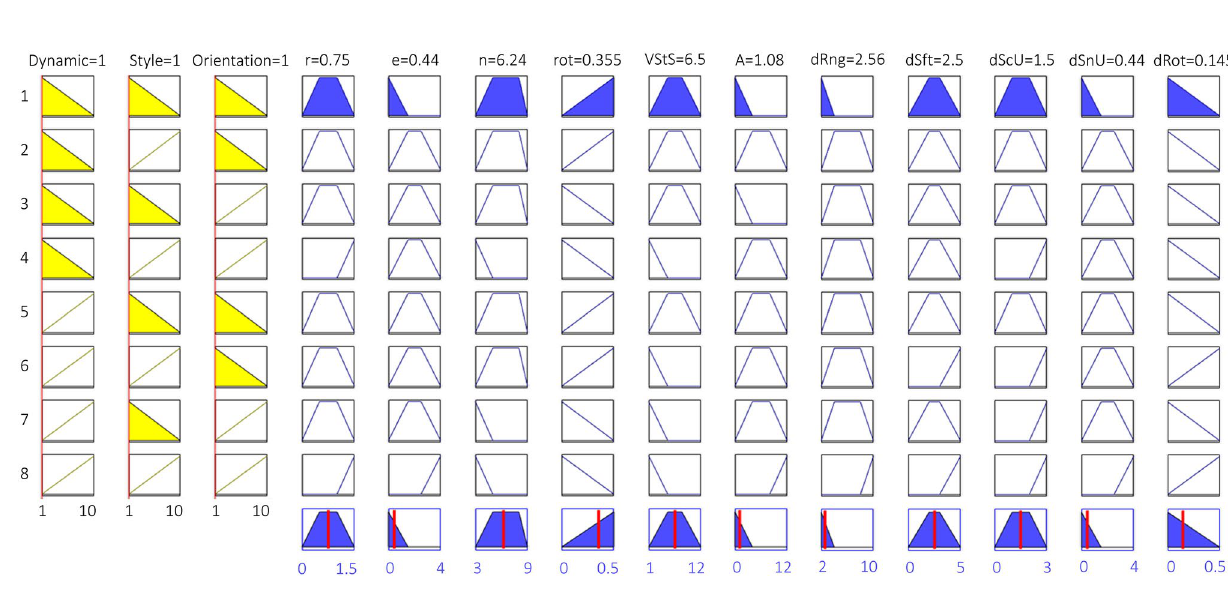
Fig. 9 Fuzzy rule set and defuzzification